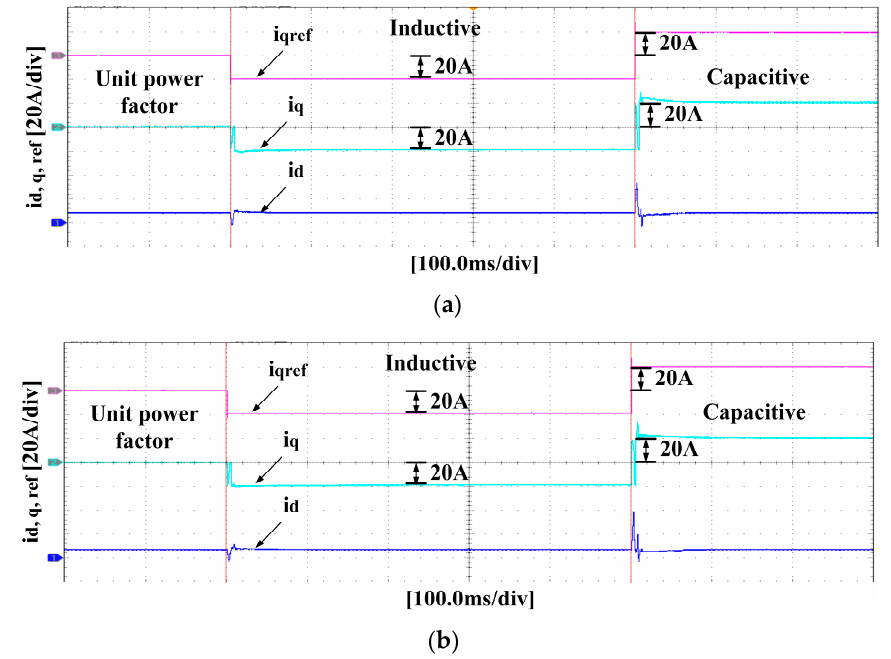
Figure 14. Experimental waveforms of the active and reactive current of the CHBR under different working conditions by use of ( a ) the proposed control strategy and ( b ) the conventional control strategy.